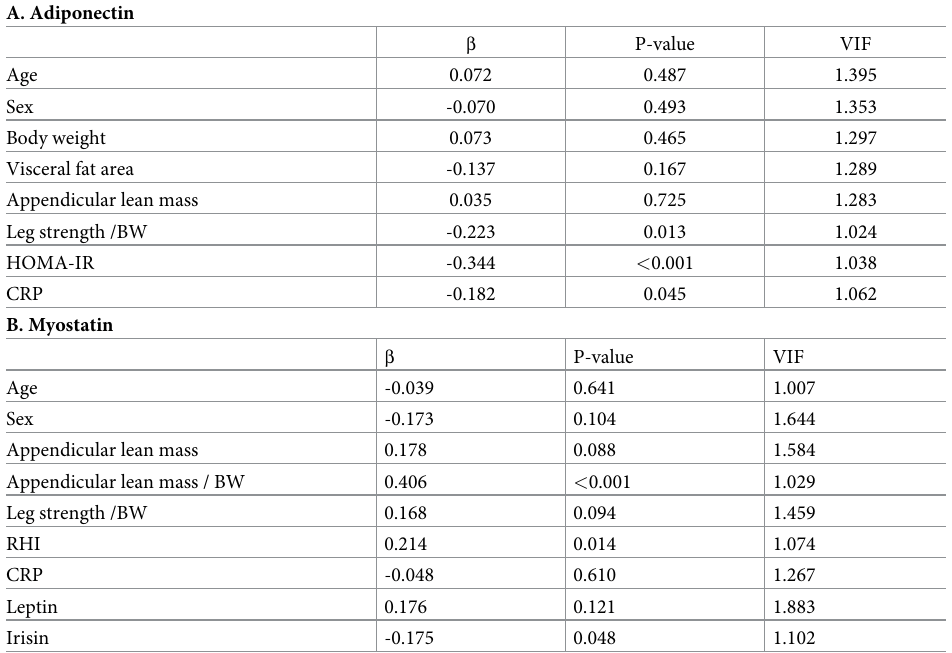
Table 3. Stepwise regression analysis for adiponectin and